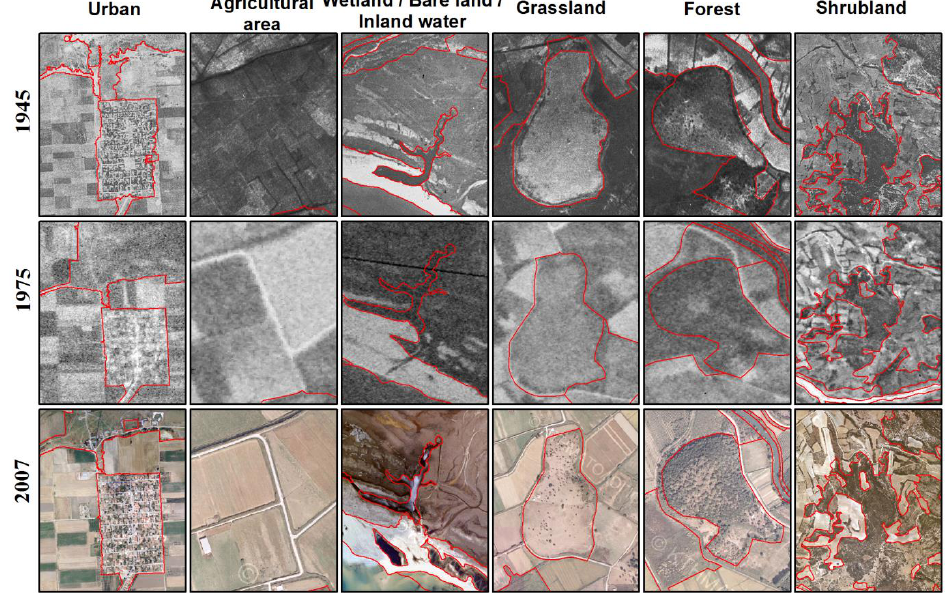
Figure 3. Series of aerial photographs (1945, 1975, 2007) used for the creation of thematic land use/land cover (LULC) maps and spatial matching following their geometric correction and adjustment. A section of Kalamas Delta is shown here as an example.